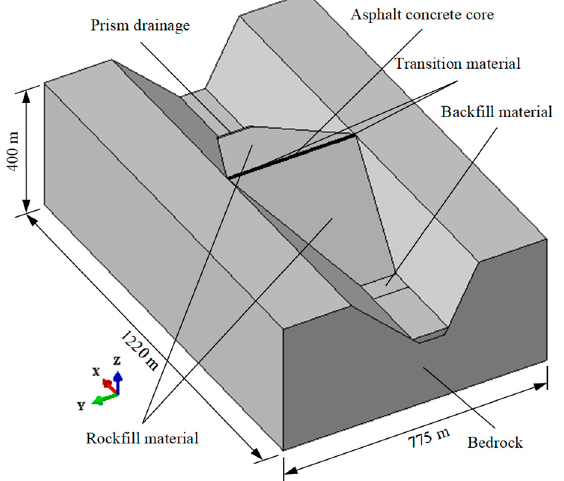
Figure 3. Diagram of calculation schemes .